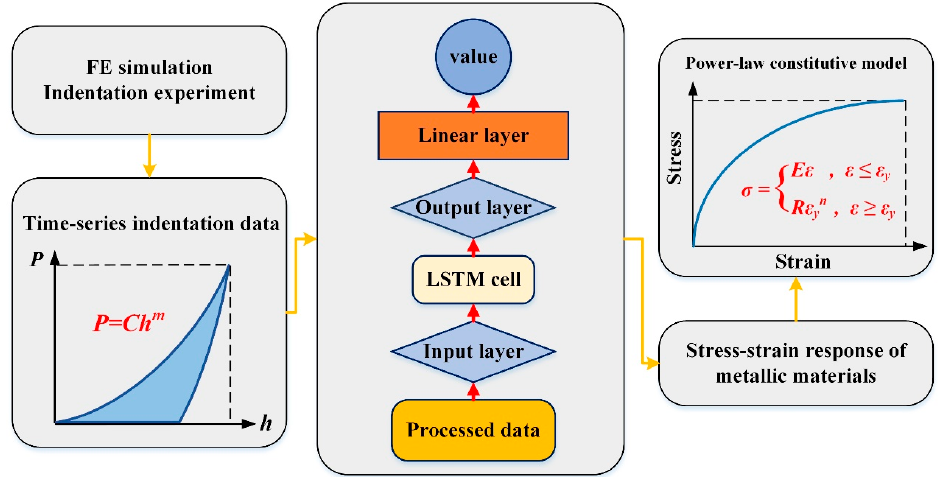
Figure 3. Work process of LSTM neural network.